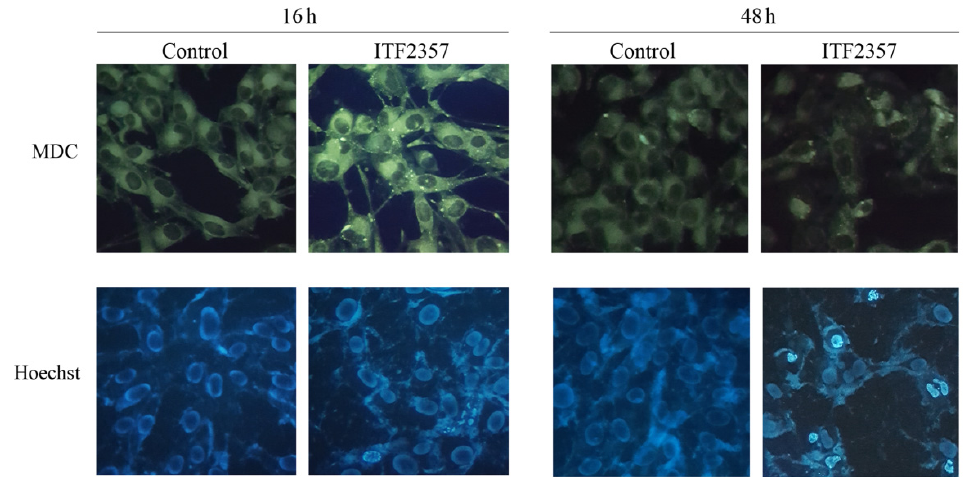
Figure 6. ITF2357 induces autophagic vacuolization and chromatin condensation. SK-MEL-28 cells were incubated for 16 or 48 h in the presence 5 µ M ITF2357. At the end of incubation, cells were stained with monodansylcadaverine (MDC), which highlights autophagic vacuoles or Hoechst 333428 and permits the visualization of nuclei. Cells were then visualized under fluorescence microscope Leika equipped with a DAPI filter (Hoechst 333428) or FITC filter (MDC) at magnification of × 400. Micrographs are representative of two different fields from two independent experiments.